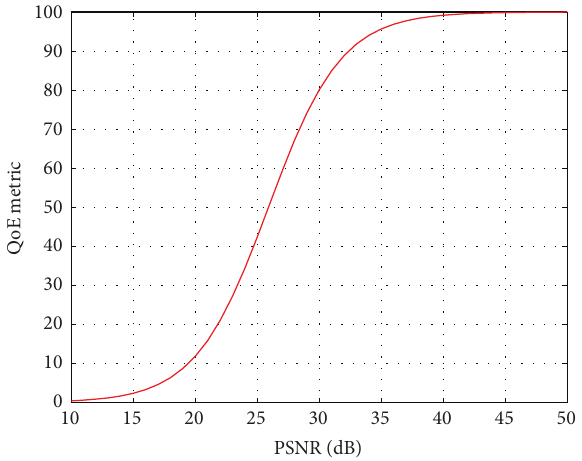
Figure 5: QoE metric versus PSNR for the football video